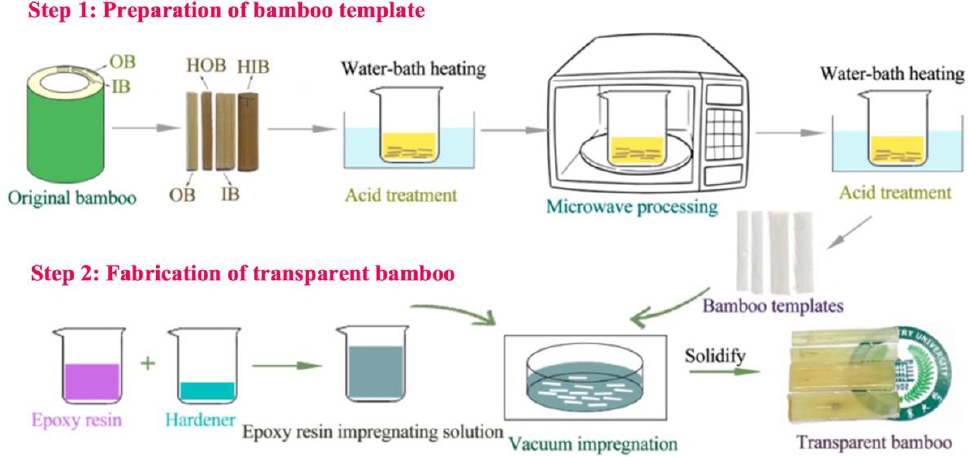
Figure 8. Preparation process of TB by microwave-assisted acidic treatment. Reprinted from [34] under CC-BY license.